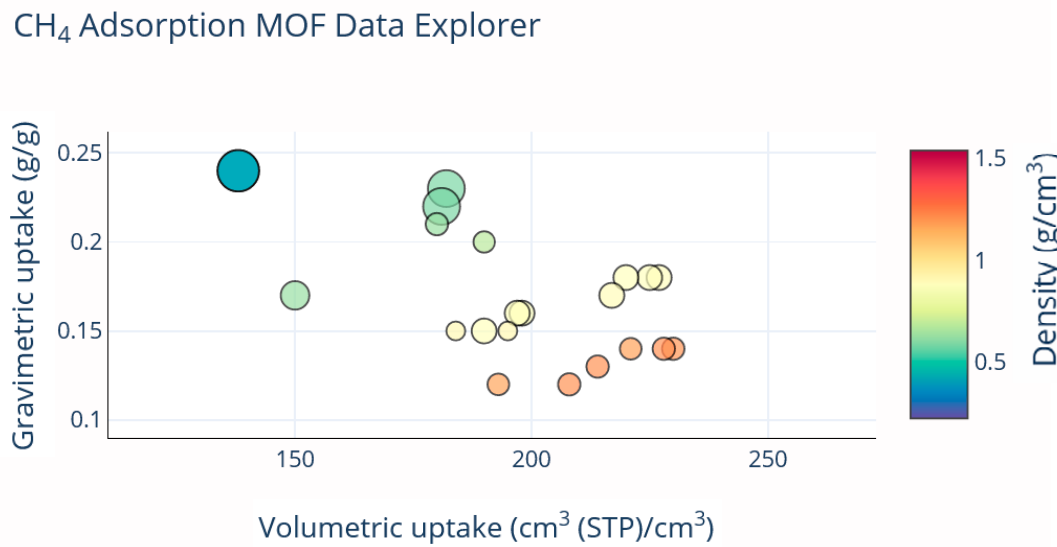
Figure 3. Quantitative structure–property relationship (QSPR) for CH 4 storage in MOFs. CH 4 volumetric and gravimetric uptake at 298 K and 35 bar. Each point represents a MOF. The data points are color coded for the density of the MOF and the diameter of each circle represents the largest cavity diameter (LCD) of the MOF.